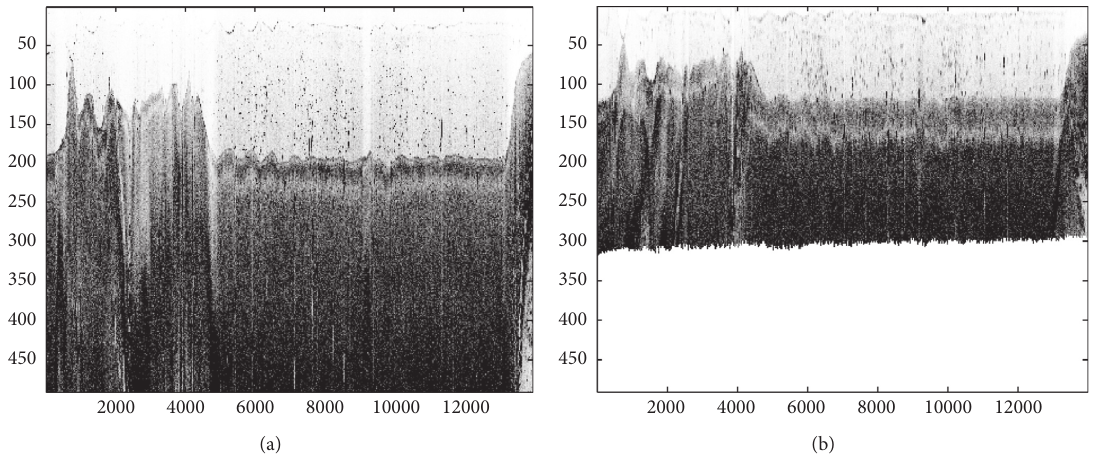
Figure 6: Separate SSS images of the port and starboard sides without blind zone: (a) port side and (b) starboard